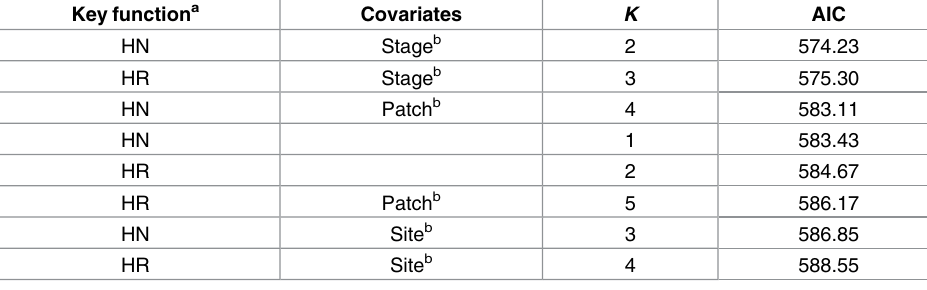
K = Number of parameters in the model